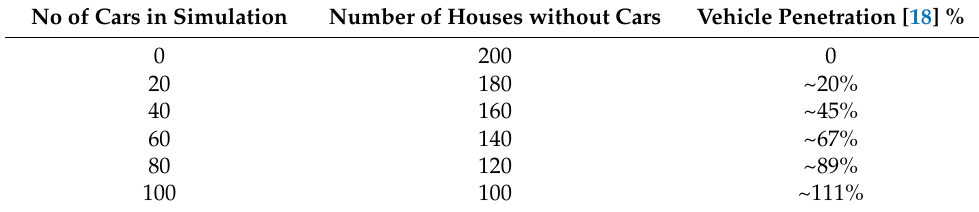
Table 2. EV penetration scenarios for network